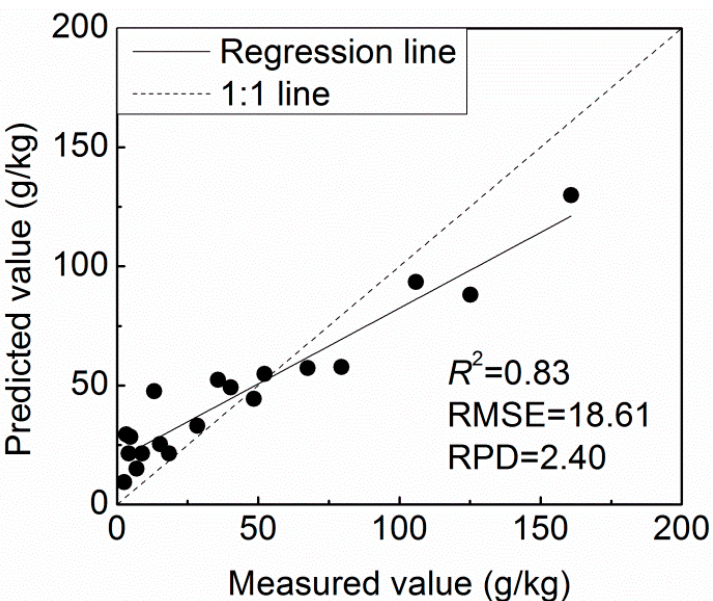
Figure 4. Comparison of estimated and measured values of soil organic matter (SOM) content by simple linear regression (SLR). R 2 indicates determination of calibration, RMSE indicates root mean square error, RPD indicates the ratio of percent deviation.